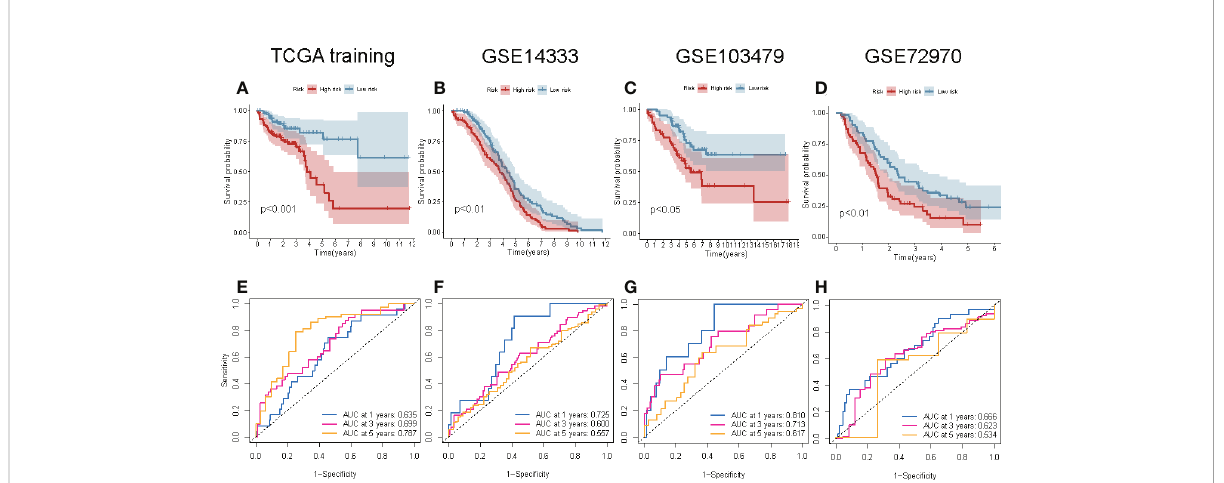
FIGURE 6 Internal and external validation of the four-gene signature prognostic risk model. (A – D) The Kaplan – Meier survival curve of the OS of patients with high-risk and low-risk scores in TCGA training, GSE14333, GSE103479, and GSE72970 cohorts. (E – H) The ROC curve of the prognostic model in TCGA training, GSE14333, GSE103479, and GSE72970 cohorts.